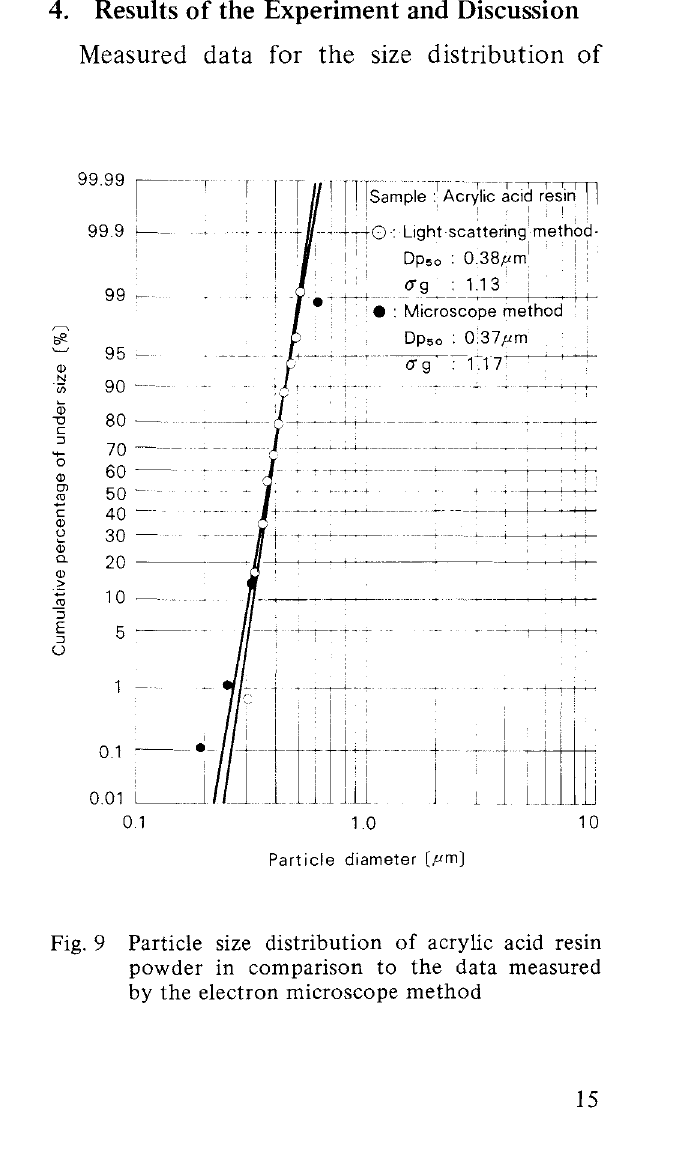
Fig. 9 Particle size distribution of acrylic acid resin powder in comparison to the data measured by the electron microscope